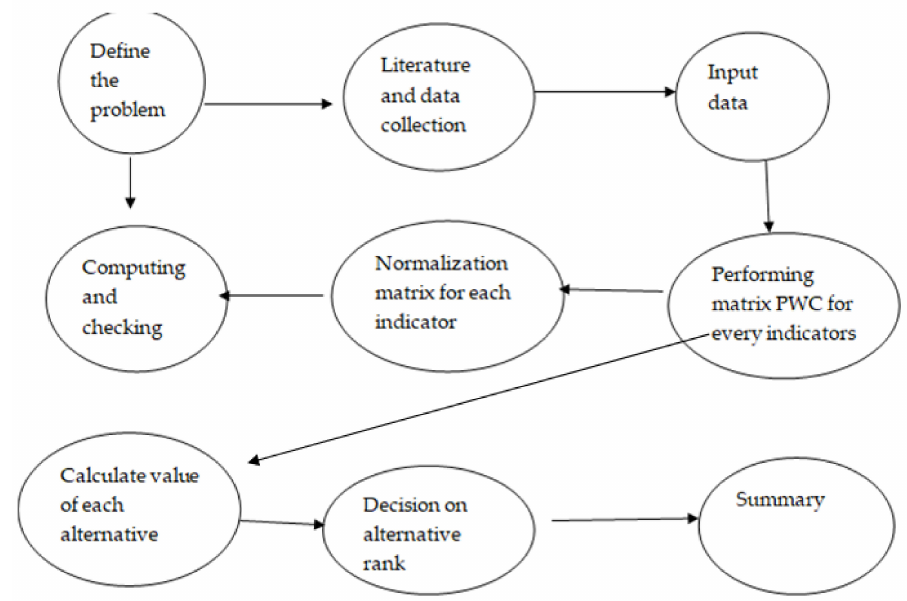
Figure 2. Steps to attain the present